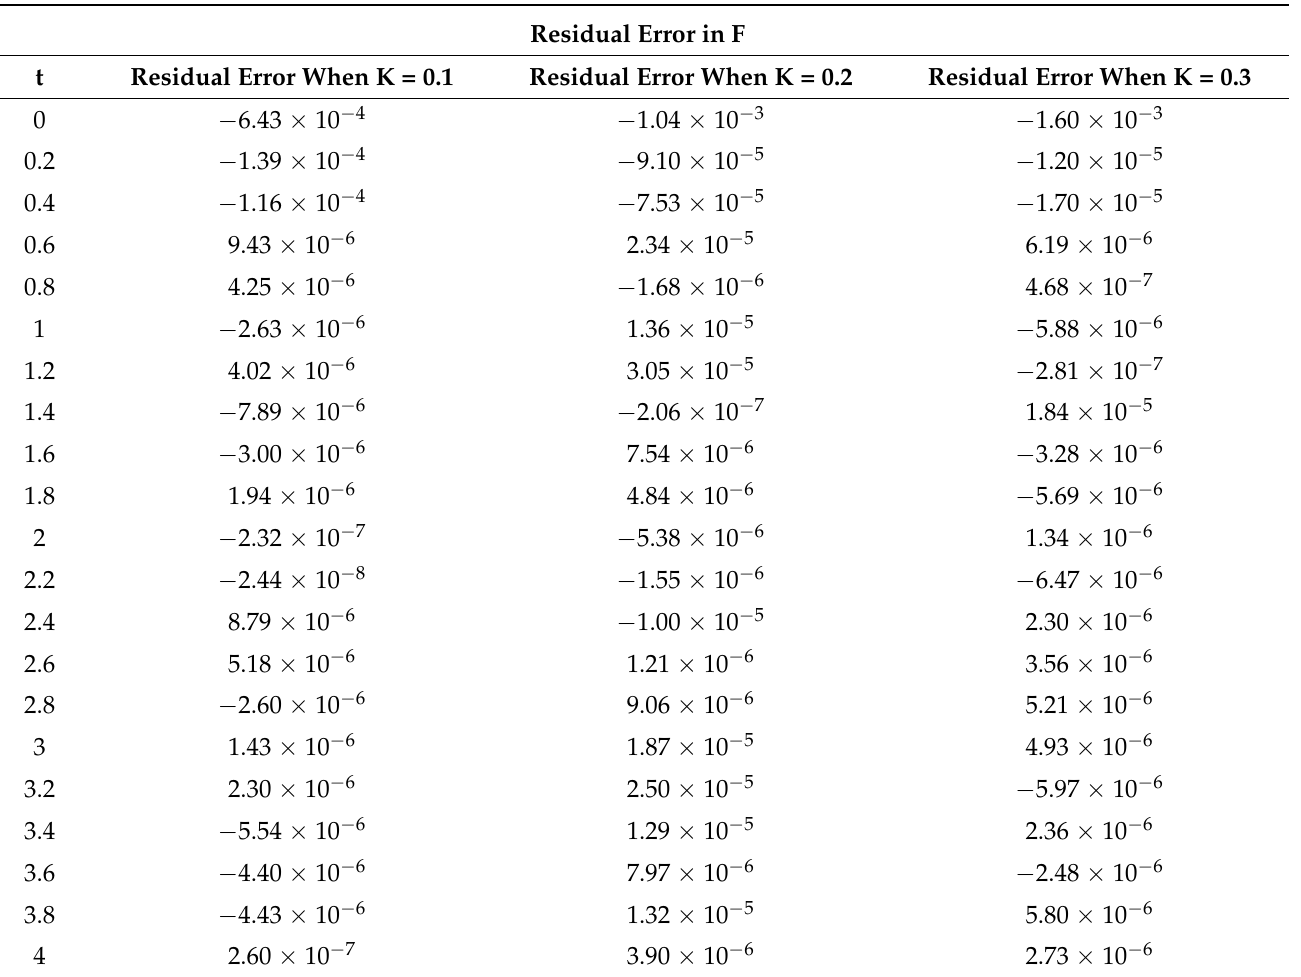
Table 7. Residual error in F when rotation parameter K varies.